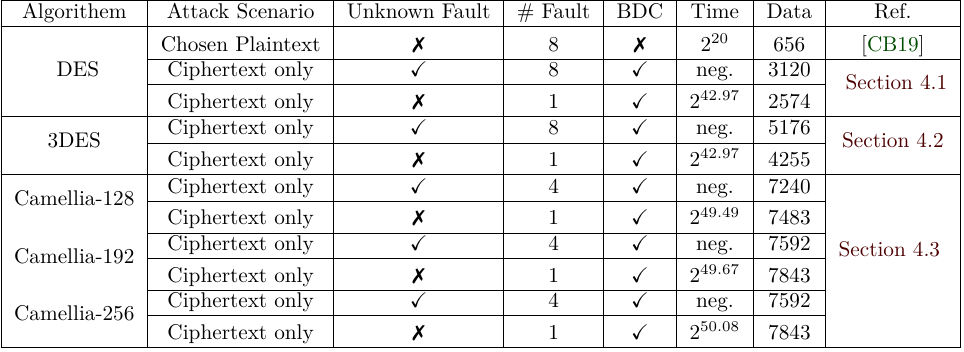
Table 1: The comparison between PFA on DES, 3DES and Camellia-128/192/256 under different assumptions, where BDC stands for by-pass Detection